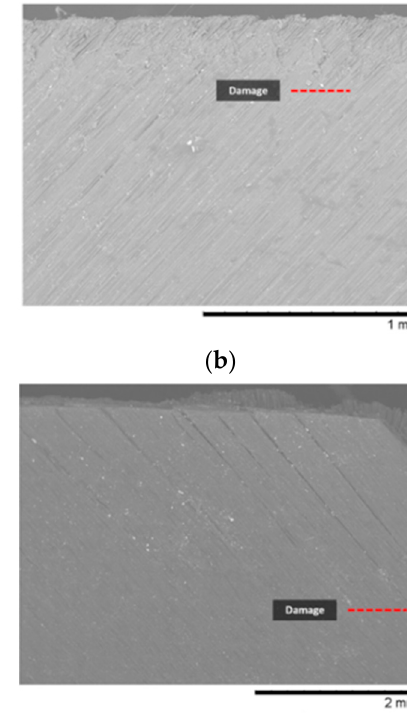
and 𝑉 (cid:3030) (cid:3404) 570 mm/min. and V c = 570 mm/min.